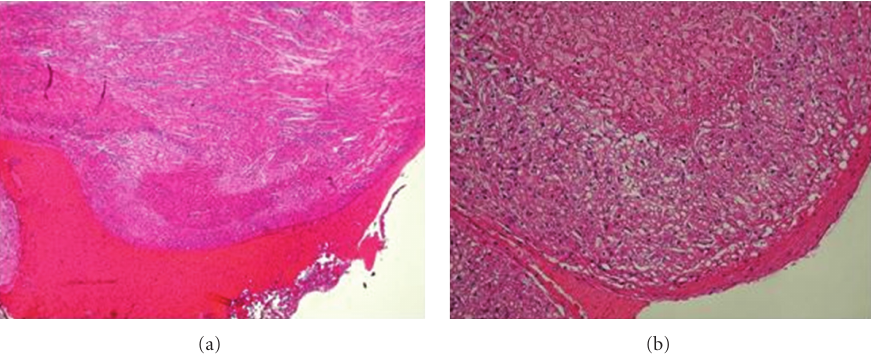
Figure 2: (a) Histology—showing a zone of myocardial infarction, (b) Histology—an increase of eosinophilia.